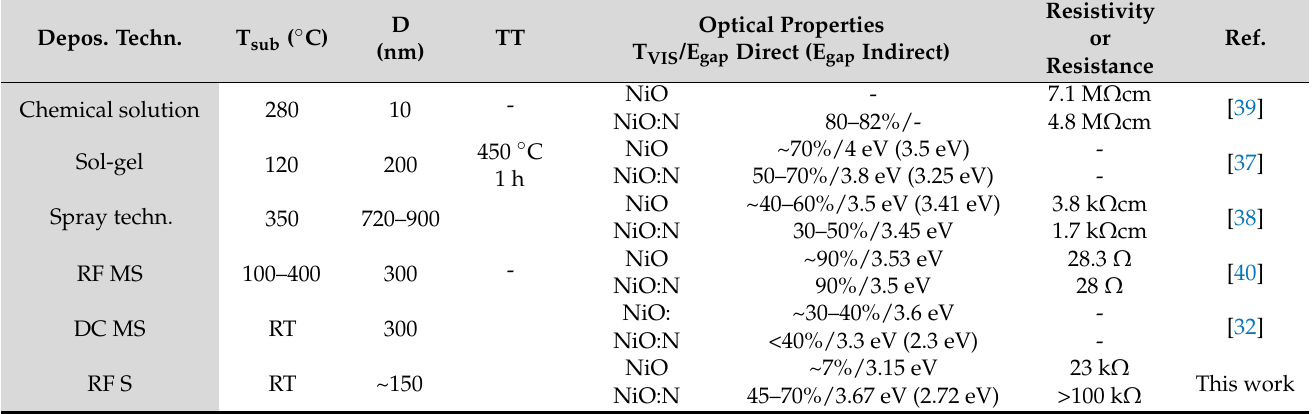
Table 1. Literature reports on NiO:N thin films properties: Depos. Techn. = deposition technique, T sub = substrate’s temperature, d = thickness, TT = thermal treatment, T VIS = visible transmittance, E gap = energy band gap, RF MS = radio frequency magnetron sputtering, DC MS = direct current magnetron sputtering, RF S = radio frequency sputtering. Depos. Techn.